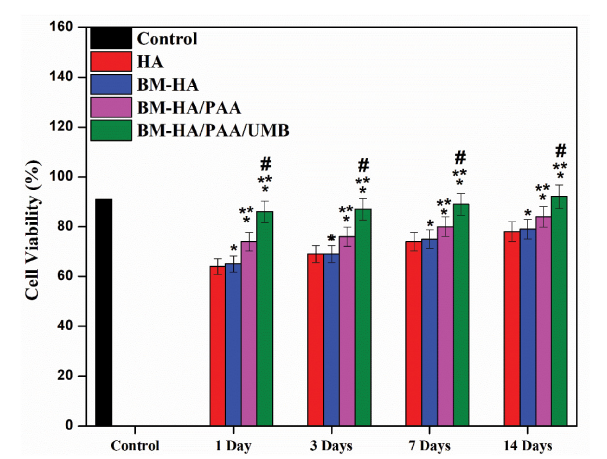
FIGURE 7 | The hBMSC viability on different composites *Comparison of the indicated group with control cells within the same set; p < 0.05. # Comparison of the indicated group with HA composite within the same set; p < 0.05. **Comparison of the indicated group with BM-HA composite within the same set; p <